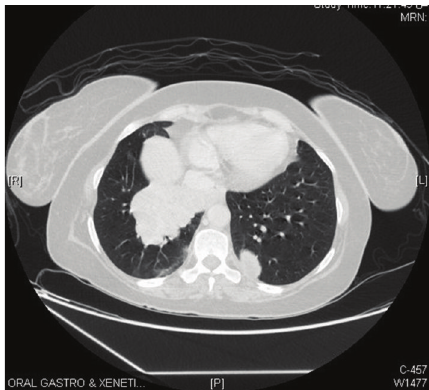
Figure 4: Computed tomography of chest showing largest pul- monary metastatic nodule of size 10 × 6 cm in right middle and lower lobes invading adjacent mediastinum, mediastinal pleura, pericardium, and right pulmonary vein and bronchus.